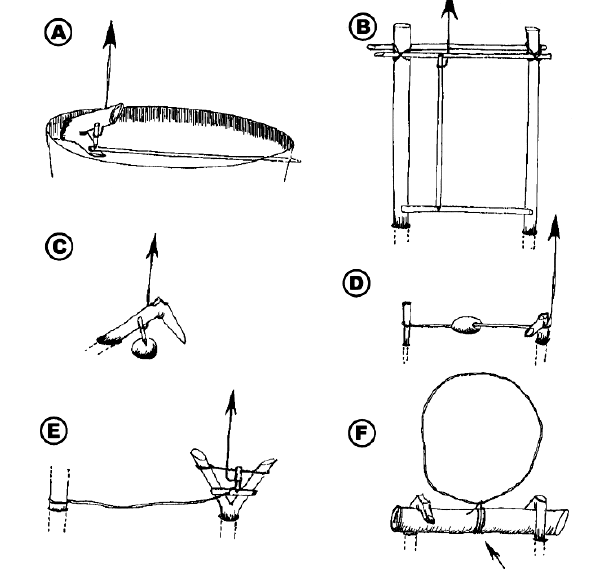
Fig. 8 . Basic systems of Fang traps (please refer to Table 1